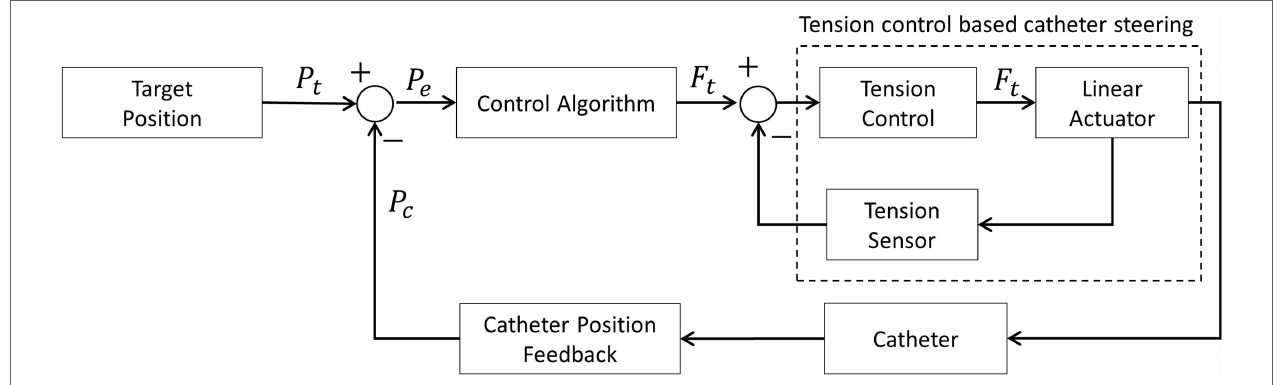
FigUre 8 | Tension based position control diagram